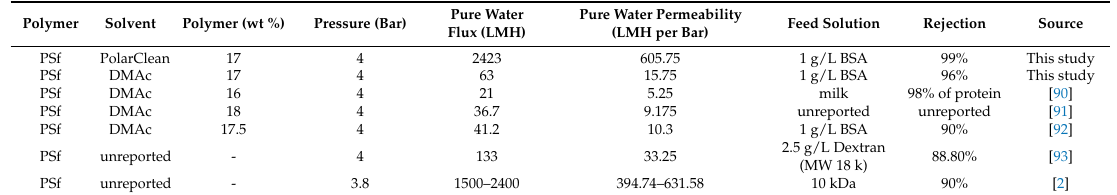
Table 4. Comparison between PSf/PolarClean membranes and literature PSf/DMAc